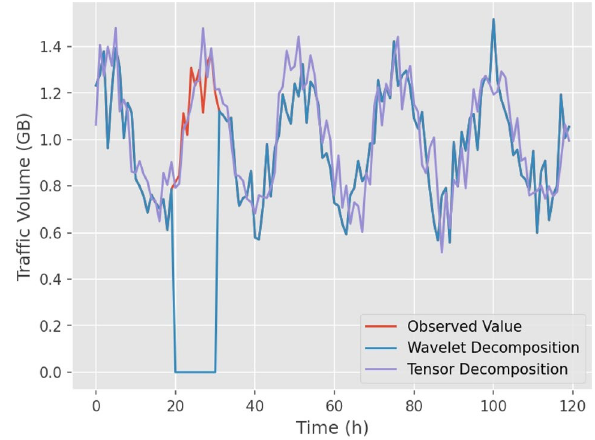
Fig. 8 Filling results of wavelet decomposition and BGCP decom- position on simulated